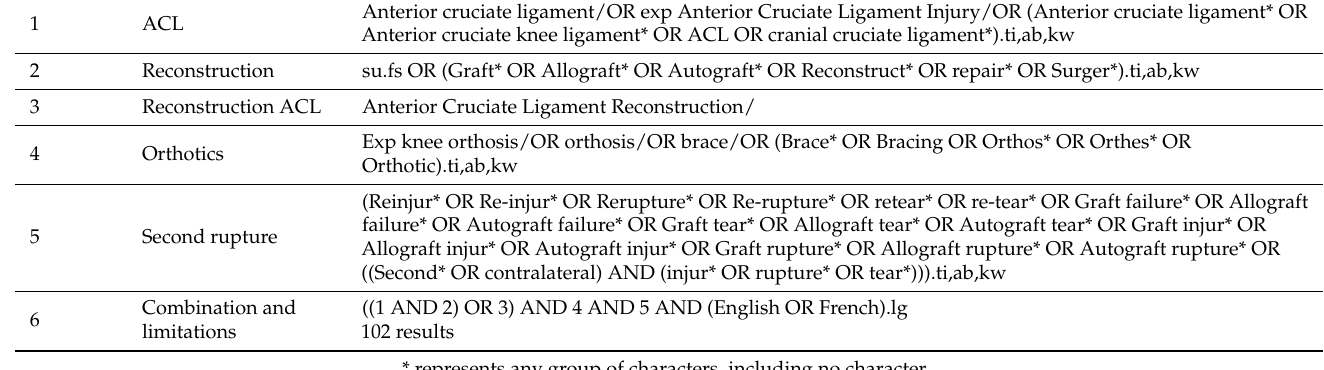
Table A4. Embase (Ovid) 9 June 2020.